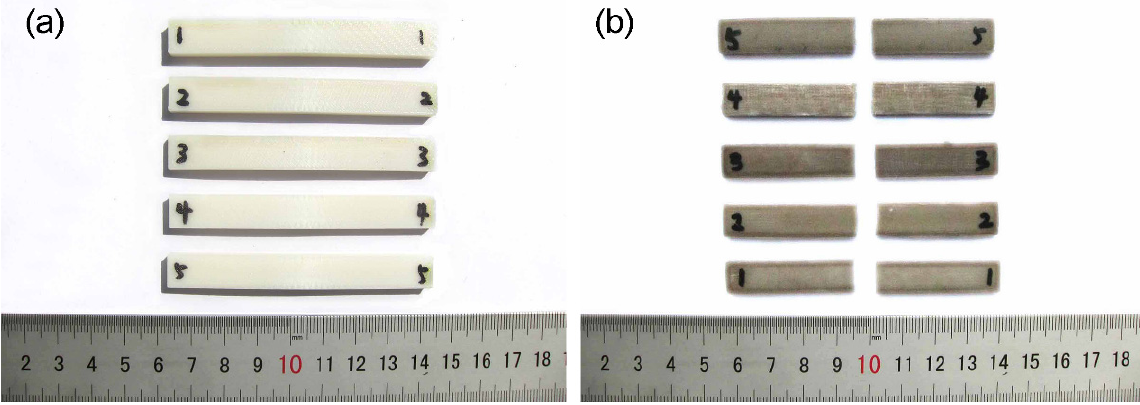
Figure 10. Fractured bending samples. ( a ) acrylonitrile butadiene styrene (ABS); ( b ) polyether-ether-ketone (PEEK).